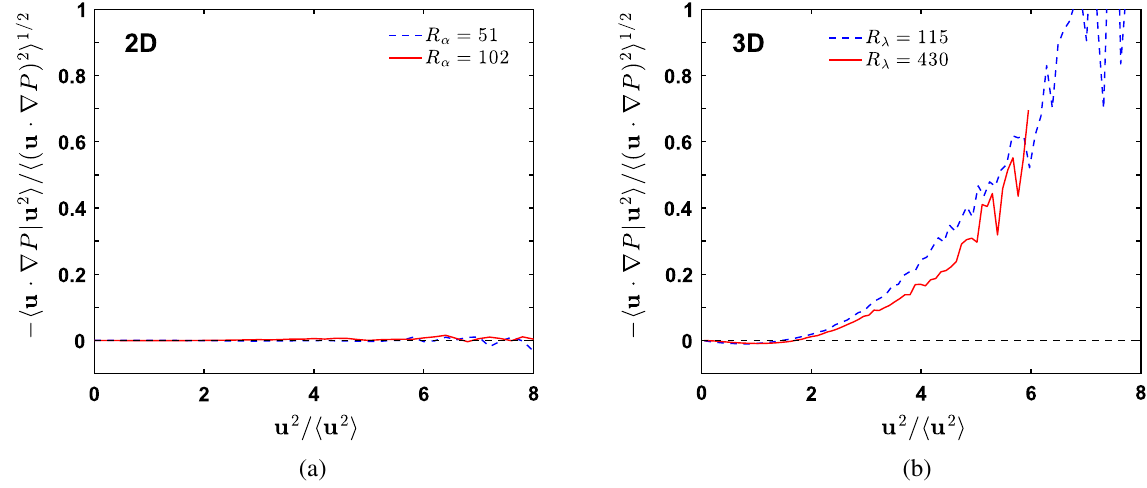
FIG. 3. The role of pressure in redistributing kinetic energy among fluid particles points to the dramatic difference between 2D and 3D turbulence. (a) The average of the pressure-gradient term conditioned on the kinetic energy of the fluid particle, h − u · ∇ P j u 2 i , in 2D turbulence (DNS data at R α ¼ 51 and R α ¼ 102 ). The average of − u · ∇ P , conditioned on u 2 , is extremely small, and consistent with being 0, implying that, on average, pressure does not redistribute energy among particles in 2D flows. (b) The same conditional average for 3D turbulence (DNS data at R λ ¼ 115 and 430). Contrary to the 2D case, the conditional mean of the pressure term is negative for particles with small u 2 , and becomes strongly positive for larger values of u 2 , which implies that, on average, the pressure term in 3D turbulence takes energy from slow particles and gives to fast particles. This leads to a runaway effect and can be stopped only by viscous